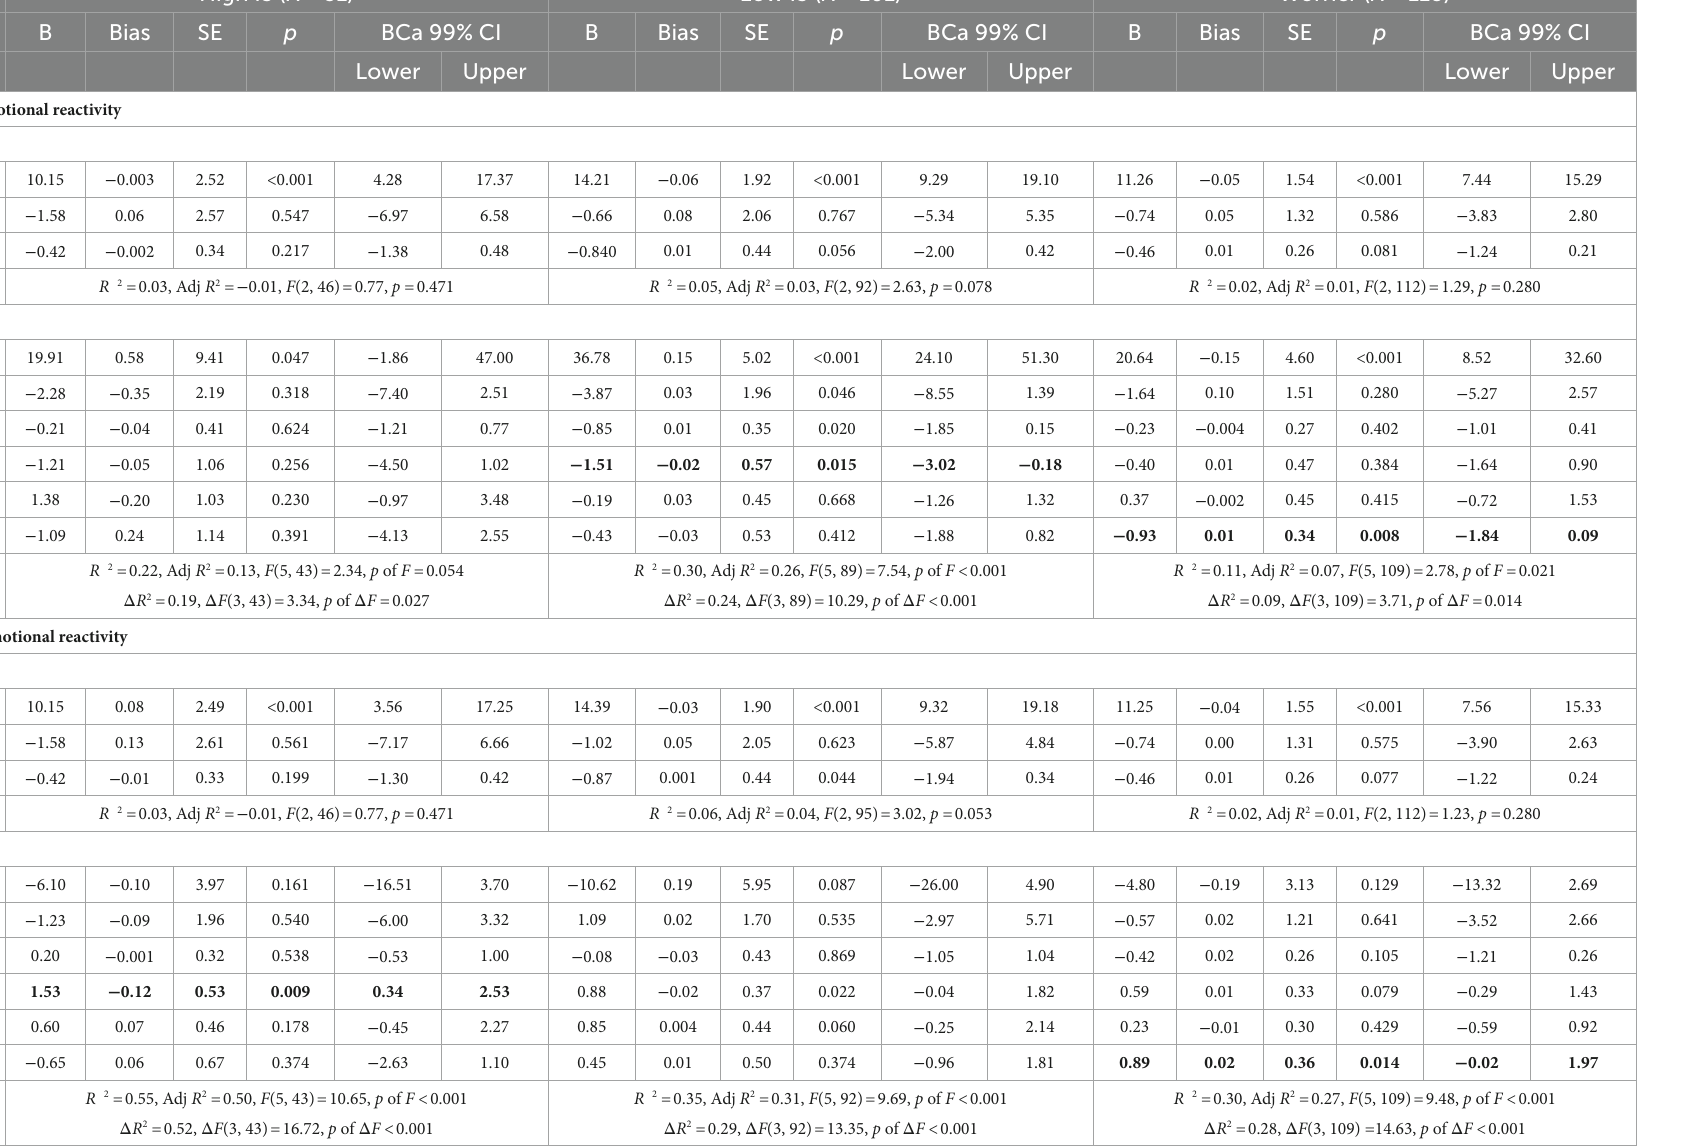
TABLE 4 Bootstrap coefficients of positive and negative emotional reactivity on depression. High IS ( N =